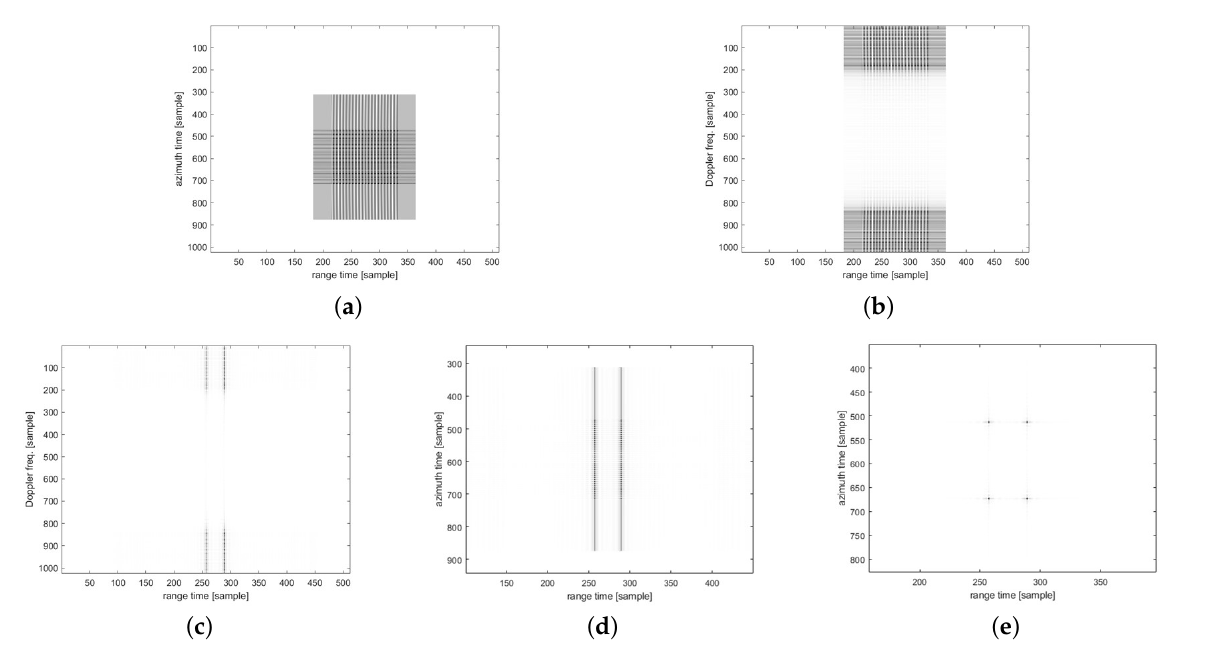
Figure 10. Point target simulation results with traditional CSA flow: ( a ) raw data in time domain; ( b ) differential RCMC result in R/D domain; ( c ) range compression and bulk RCMC result in R/D domain; ( d ) range compression and bulk RCMC result in time domain; ( e ) azimuth compression result in time domain.